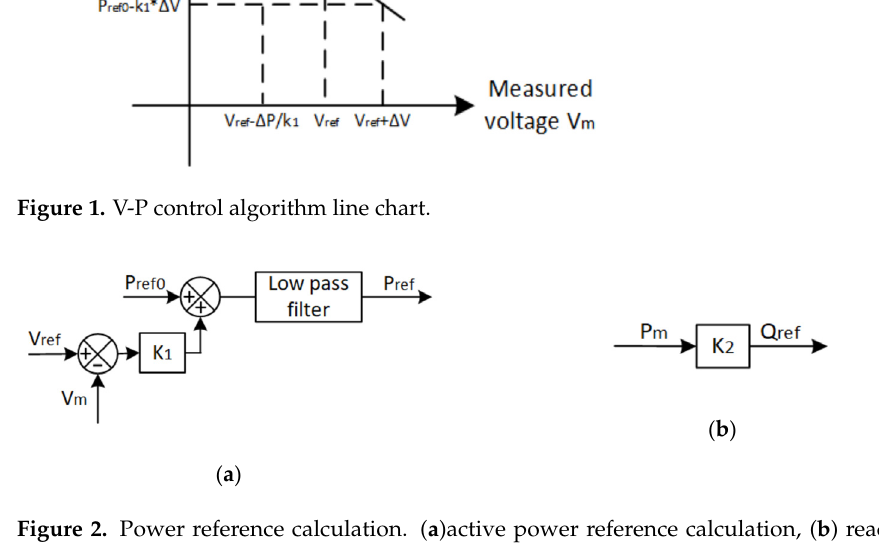
Figure 2. Power reference calculation. ( a )active power reference calculation, ( b ) reactive power reference calculation.